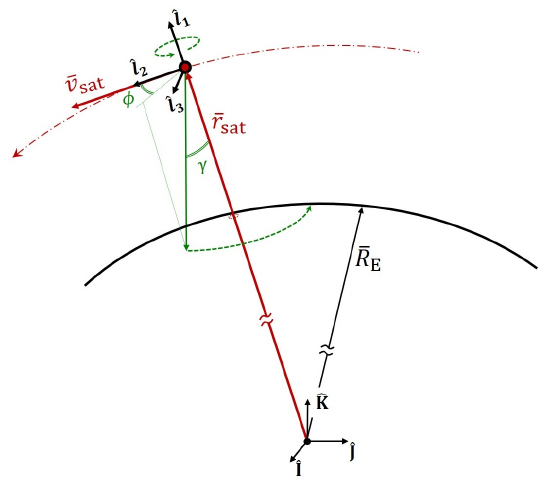
Figure 5. Illustration of the satellite-scanning geometry. The bore- sight direction (solid green arrow) is identified by the elevation an- gle γ = 38 ◦ with respect to the nadir direction and by the azimuth angle φ measured from the horizontal direction ˆ l 2 of the local– vertical/local–horizontal (LVLH) reference frame. The solid red ar- rows r sat and v sat represent the satellite’s position and velocity vec- tors in the geocentric–equatorial (IJK) reference